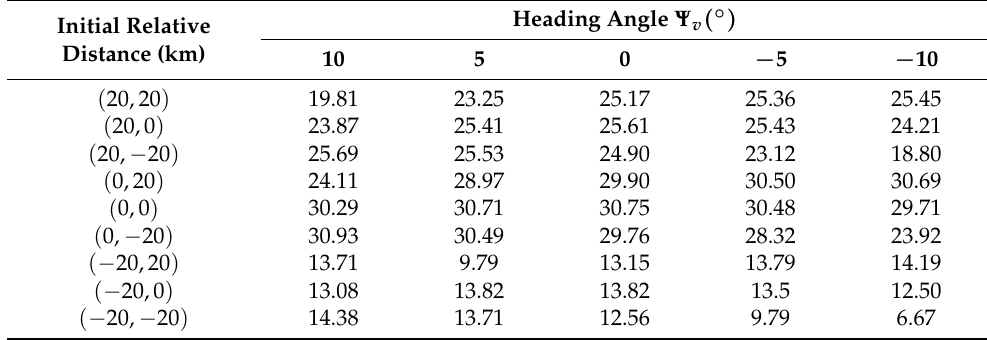
Table 5. Miss distance (m) with initial flight path angle θ = 10 ◦